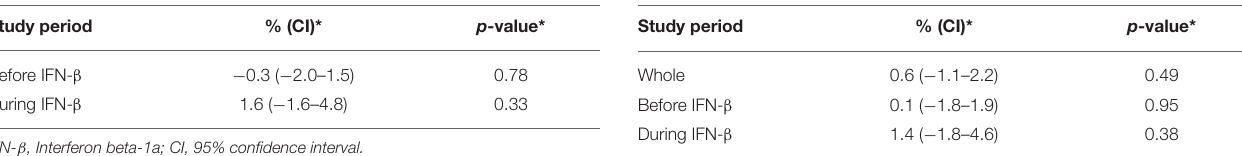
TABLE 2 | Change in serum NfL concentration with every 10 nmol/L increase of 25(OH)D. Study period